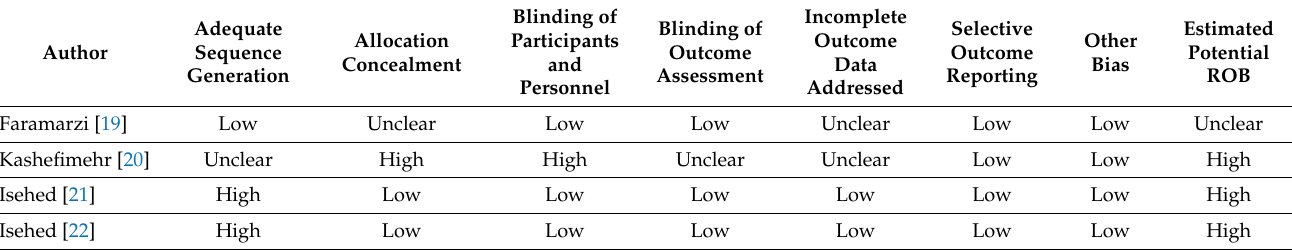
Table 2. Cochrane RoB for RCTs.